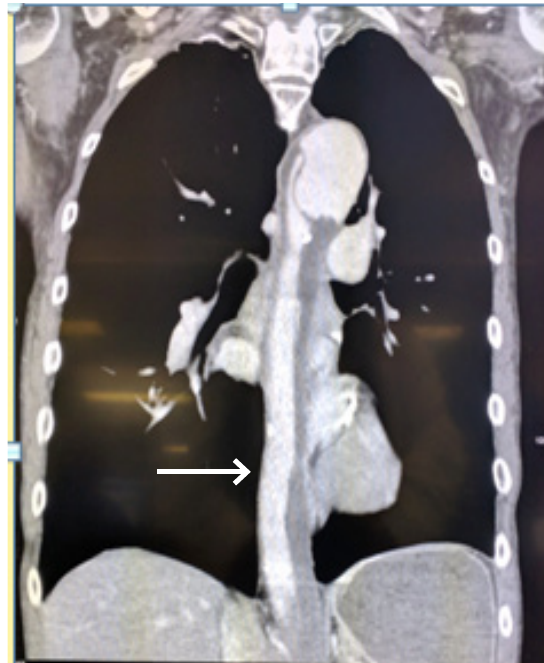
Image 1. Computed tomography of the chest in coronal view demonstrating a Stanford Type B aortic dissection